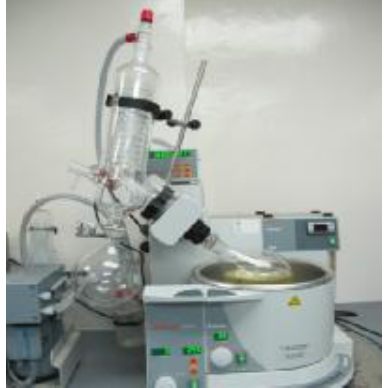
Figure 4. Rotary Evaporator Containing the Extract